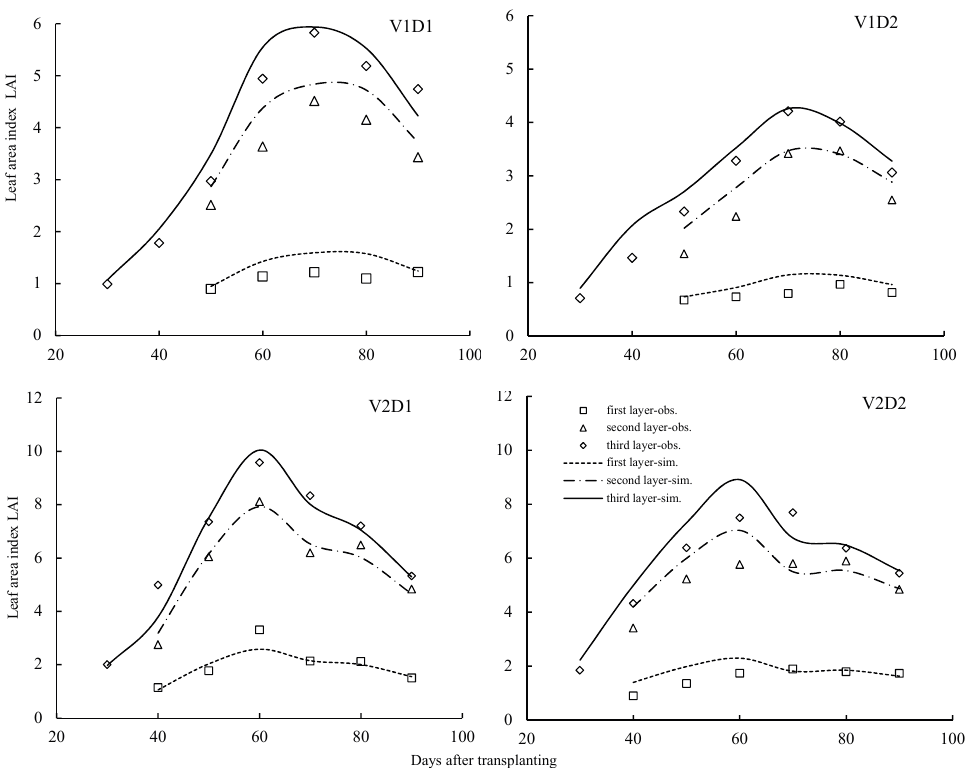
Figure 6. Comparison of simulated and observed downward cumulative LAI in rice, 2013.